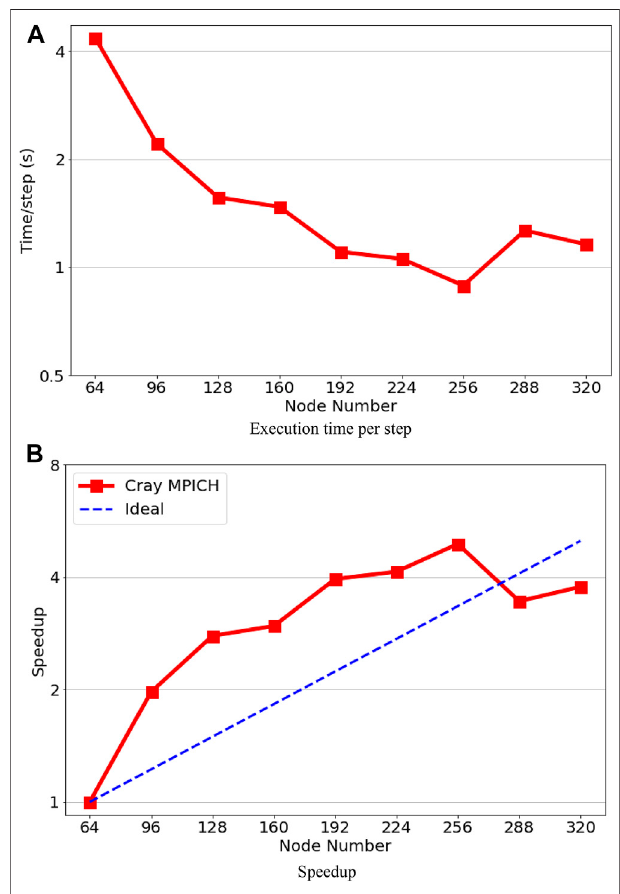
FIGURE 9 | Performance results on the Beskow system. (A) Execution time per step. (B)